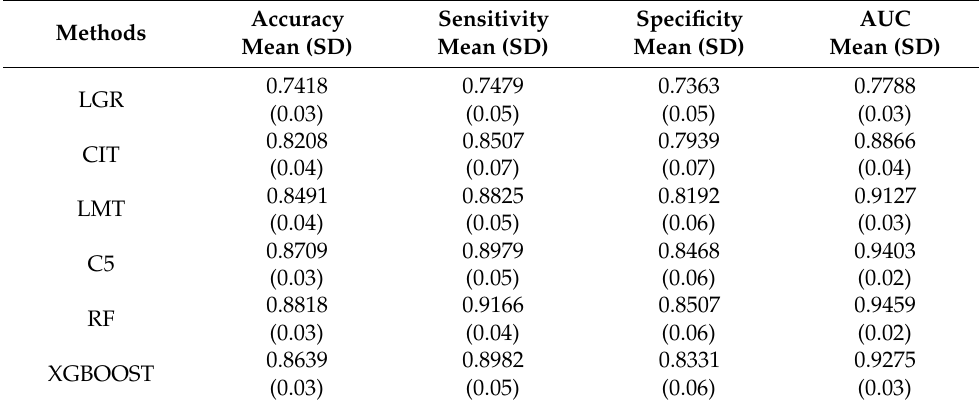
Table 2. Model performance of all methods for all glaucoma eyes.